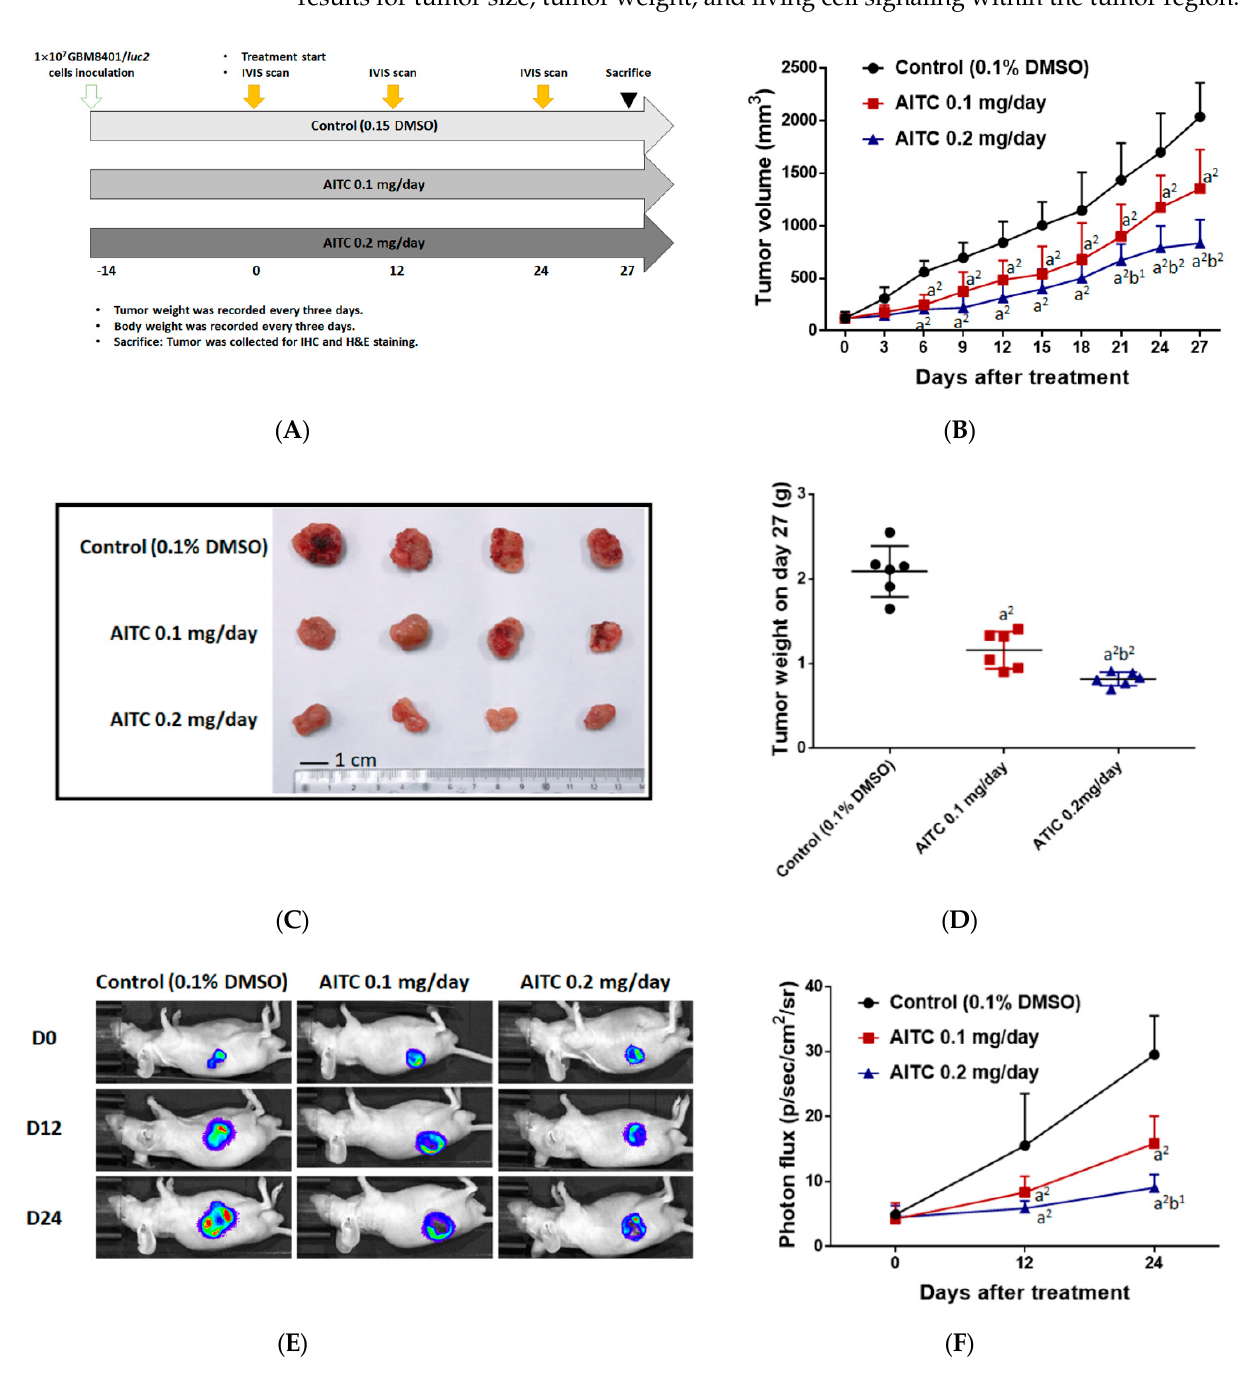
Figure 3. AITC effectively suppressed glioblastoma growth. ( A ) The animal experiment flow chart. ( B ) Tumor volume of control and AITC-treated groups (0.1 and 0.2 mg/day) from day 0 to day 27. ( C ) The representative tumor images from each group. ( D ) The tumor weights of mice on day 27. ( E ) The representative BLI results from each group at different time points. ( F ) Quantification results of luc2 signal intensity of tumors. (a 2 p < 0.01 vs. control; b 1 p < 0.05, b 2 p < 0.01 vs. AITC 0.1 mg/day). Each treatment was replicated 2 times with 4 mice per group.